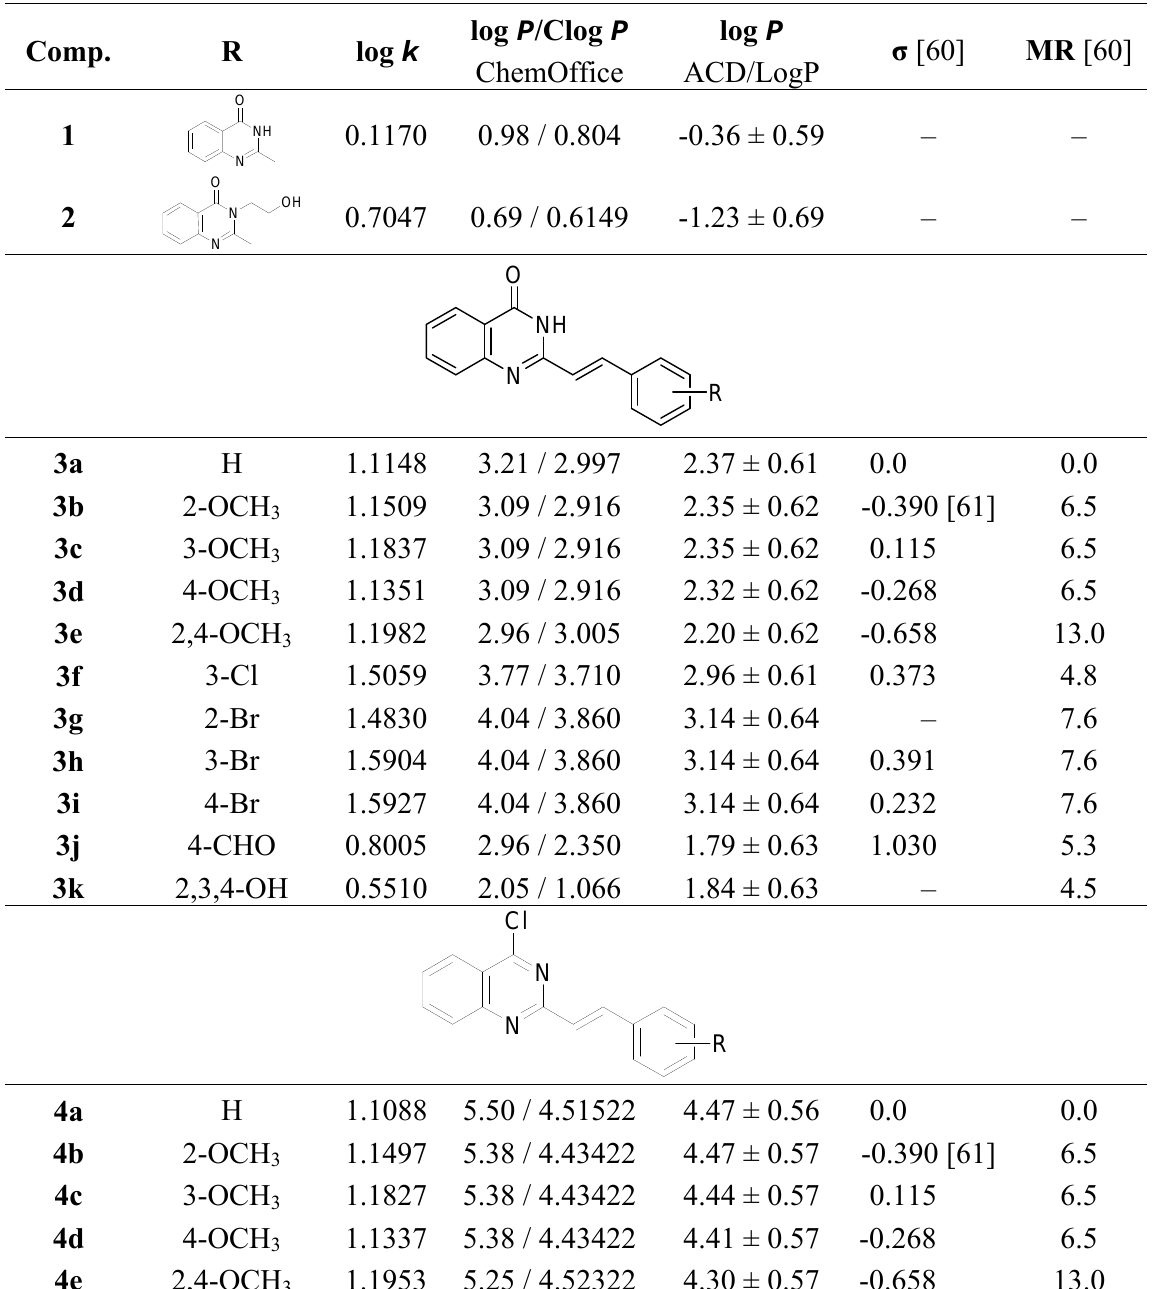
Table 1. Comparison of the calculated lipophilicities (log P /Clog P ) with the determined log k values, electronic Hammett's parameters ( σ ) and bulk parameters MR (volume of substituents)